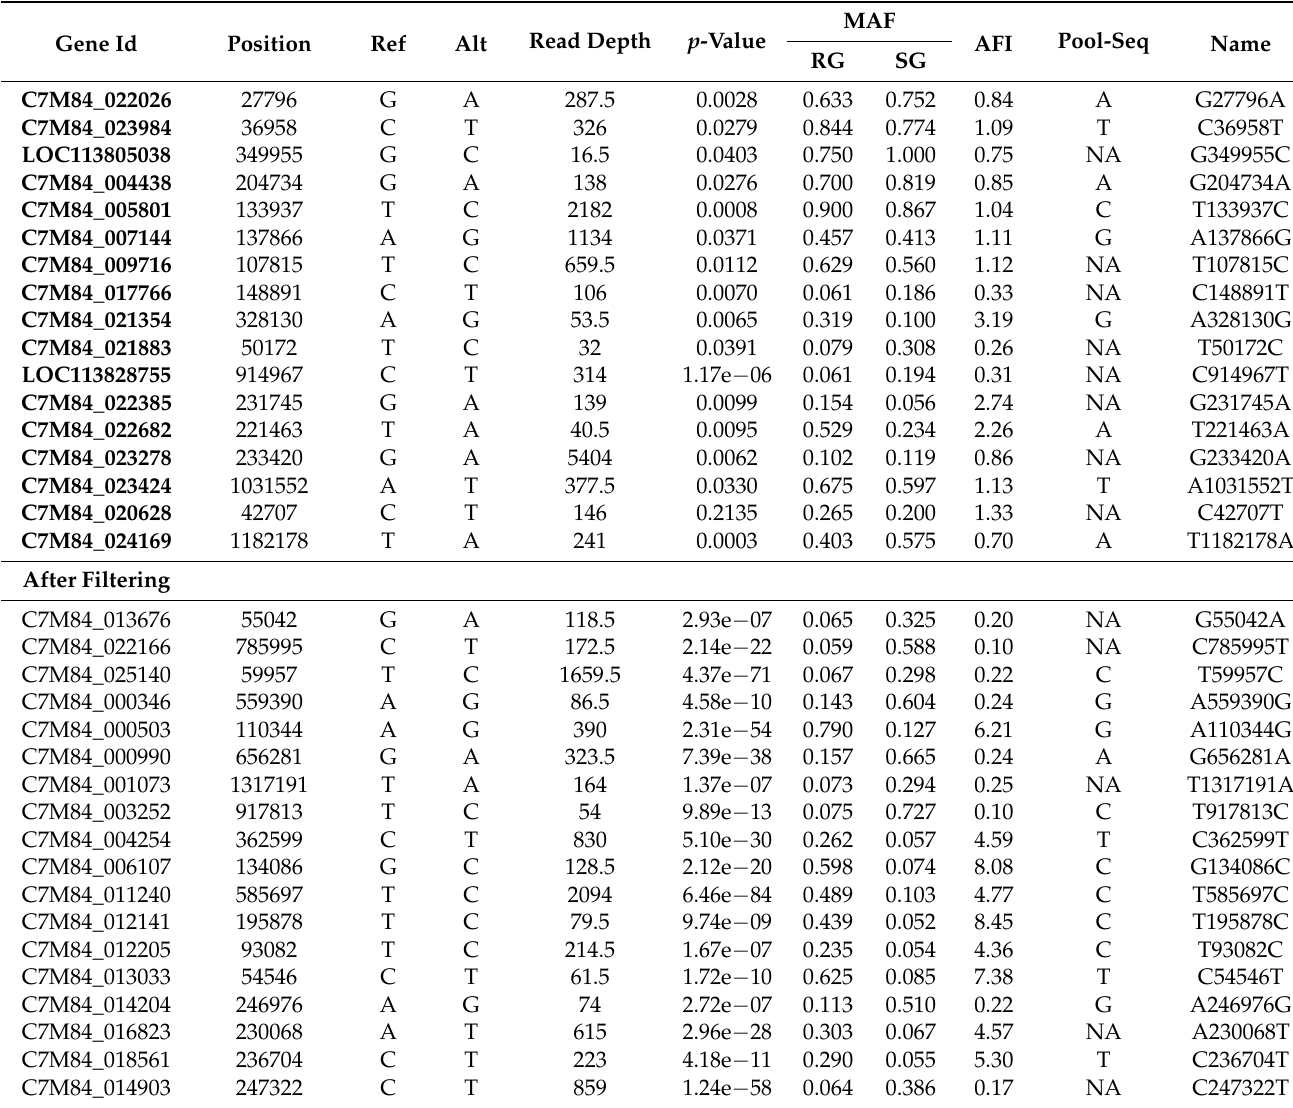
Table 6. The information for 35 target